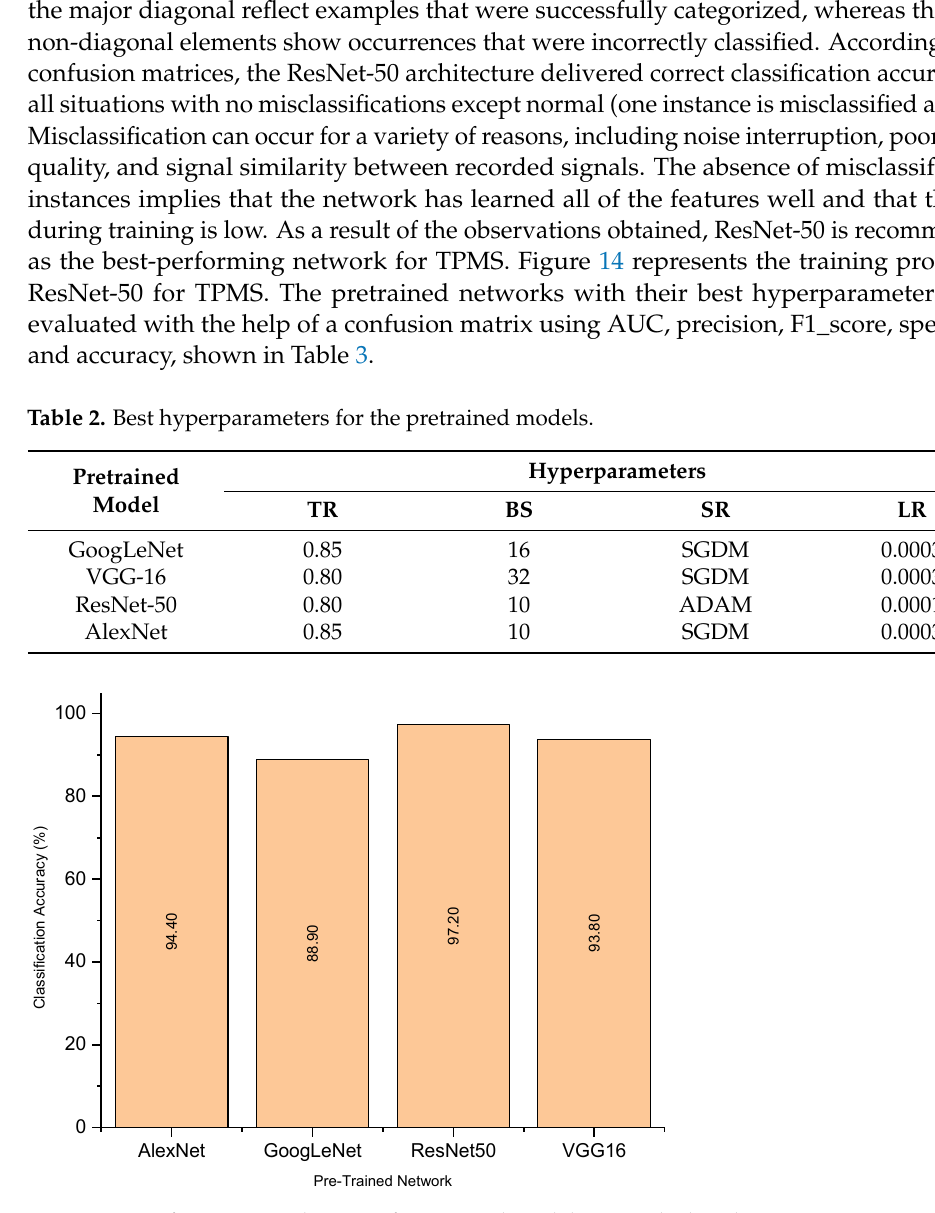
Figure 12. Performance evaluation of pretrained models using the best hyperparameters. Table 2. Best hyperparameters for the pretrained models.